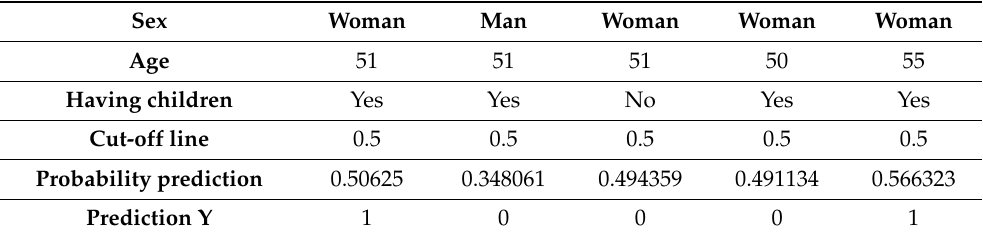
Table 14. Prediction results of selected models for different variants of